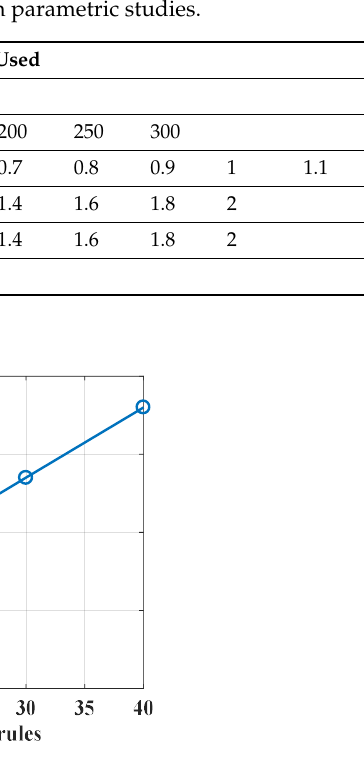
Figure 2. Influence of the number of fuzzy rules on the number of total ANFIS weight parameters to be optimized by PSO. Table 3. Characteristics of ANFIS structure.